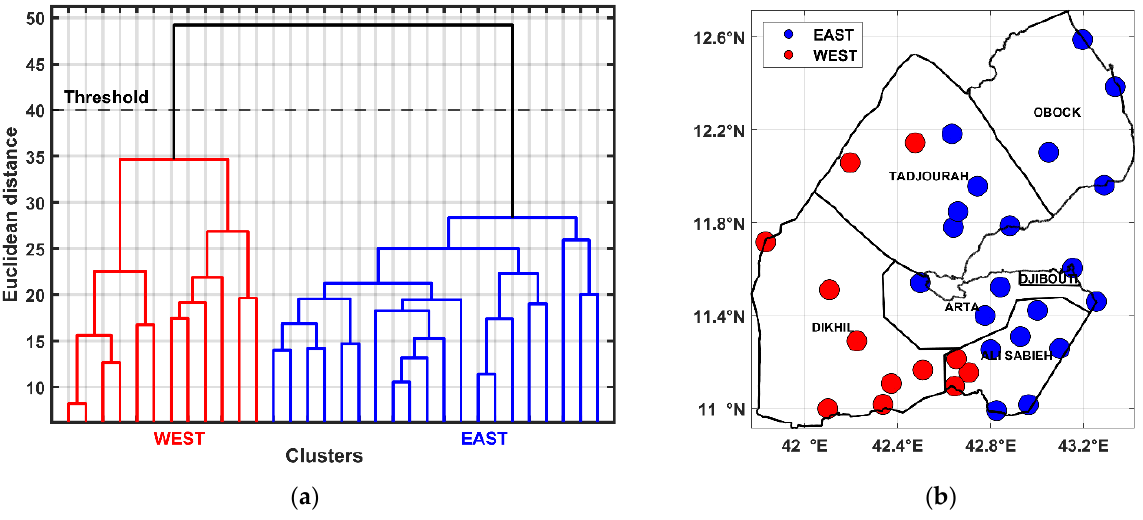
Figure 4. Dendrogram of the HAC ( a ) of mean monthly precipitation, and a map ( b ) displaying the distribution of rainfall stations belonging to the two regions (WEST and EAST).